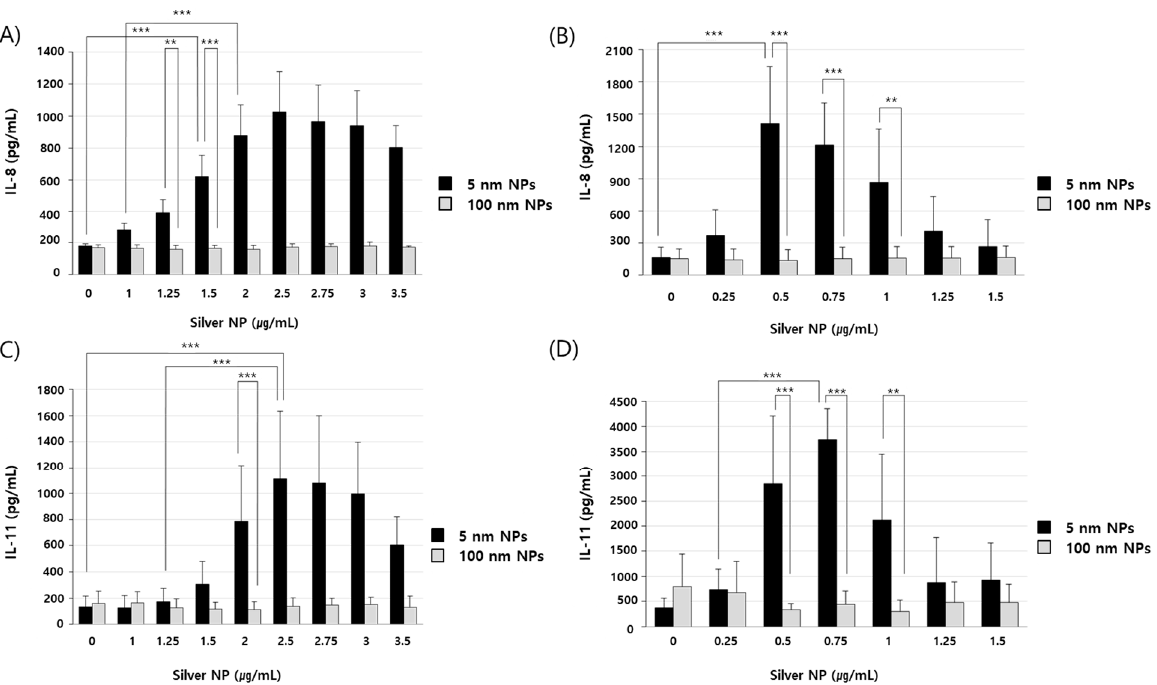
Figure 5. Dose-dependent expression of cytokines in response to silver NPs. ( A ) EA.hy926 and ( B ) BEAS-2B cells were treated with silver NPs at different doses for 8 h. ( C ) EA.hy926 and ( D ) BEAS-2B cells were treated with silver NPs at different doses for 24 h. Data represent the mean ± standard deviation of three independent experiments. One-way and two-way analysis of variance was performed to determine the significance of the differences (** p < 0.01, *** p < 0.001).